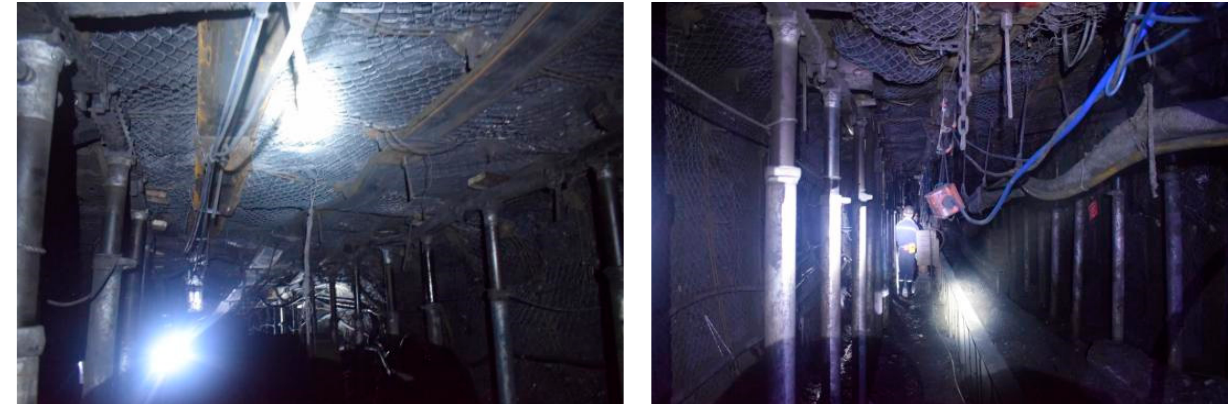
Figure 16. Effect of on-site advanced temporary support.